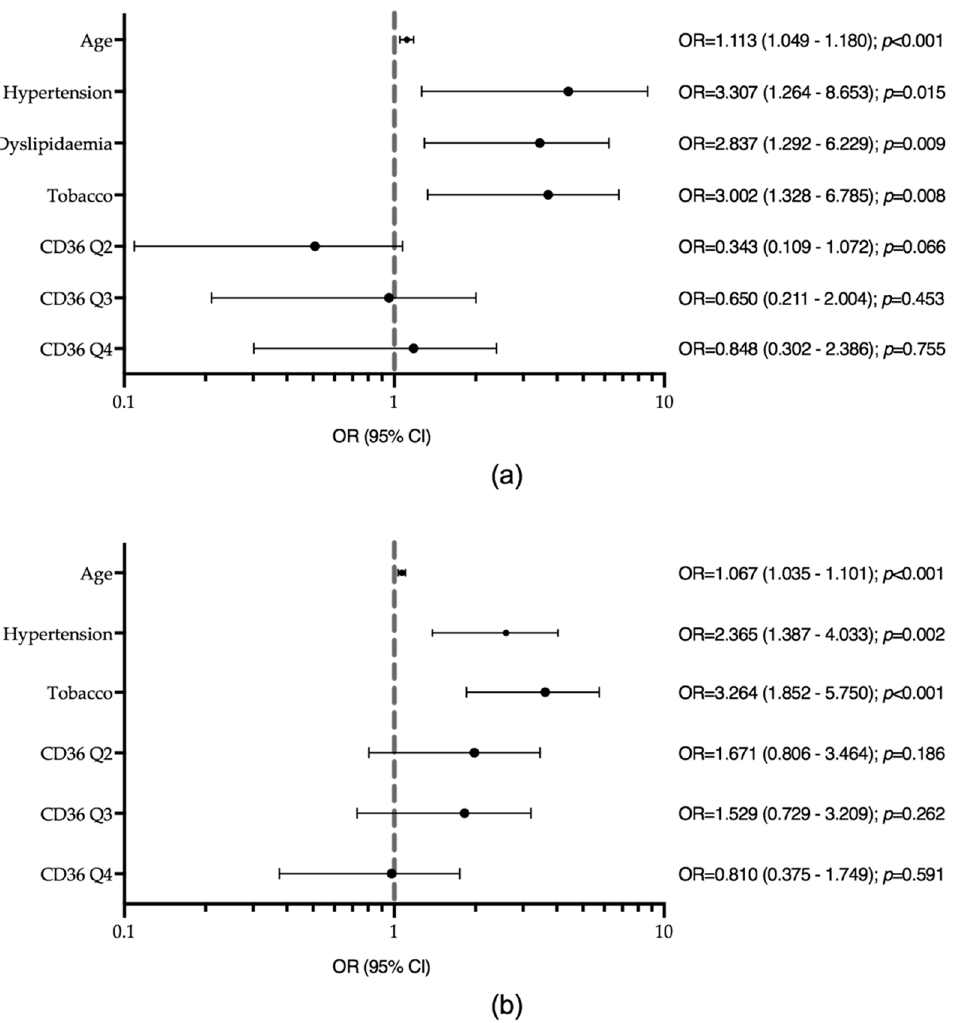
Figure 2. Logistic regression models for the presence of carotid atherosclerotic plaque ( a ) in type 1 diabetes (T1D) (Hosmer and Lemeshow test p -value = 0.144). Model adjusted by sex, haematocrit, BMI, haemoglobin and platelets. ( b ) In type 2 diabetes (T2D) (Hosmer and Lemeshow test p -value = 0.535). Model adjusted by sex, dyslipidaemia, BMI, haemoglobin, haematocrit and platelets. Tobacco, tobacco exposure; HDL, high-density lipoprotein.